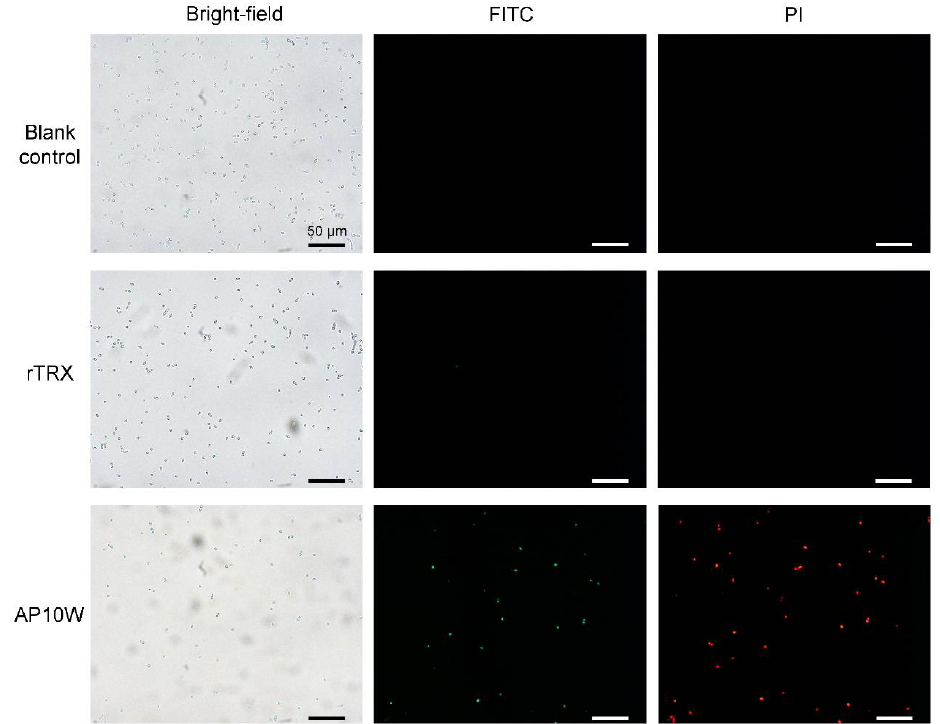
Figure 4. AP10W binds to C. albicans and causes cell wall permeabilization. rTRX was used as negative control, sterile water was used as blank control. Each test was performed in triplicate, and repeated three times. Scale bars: 50 μm.